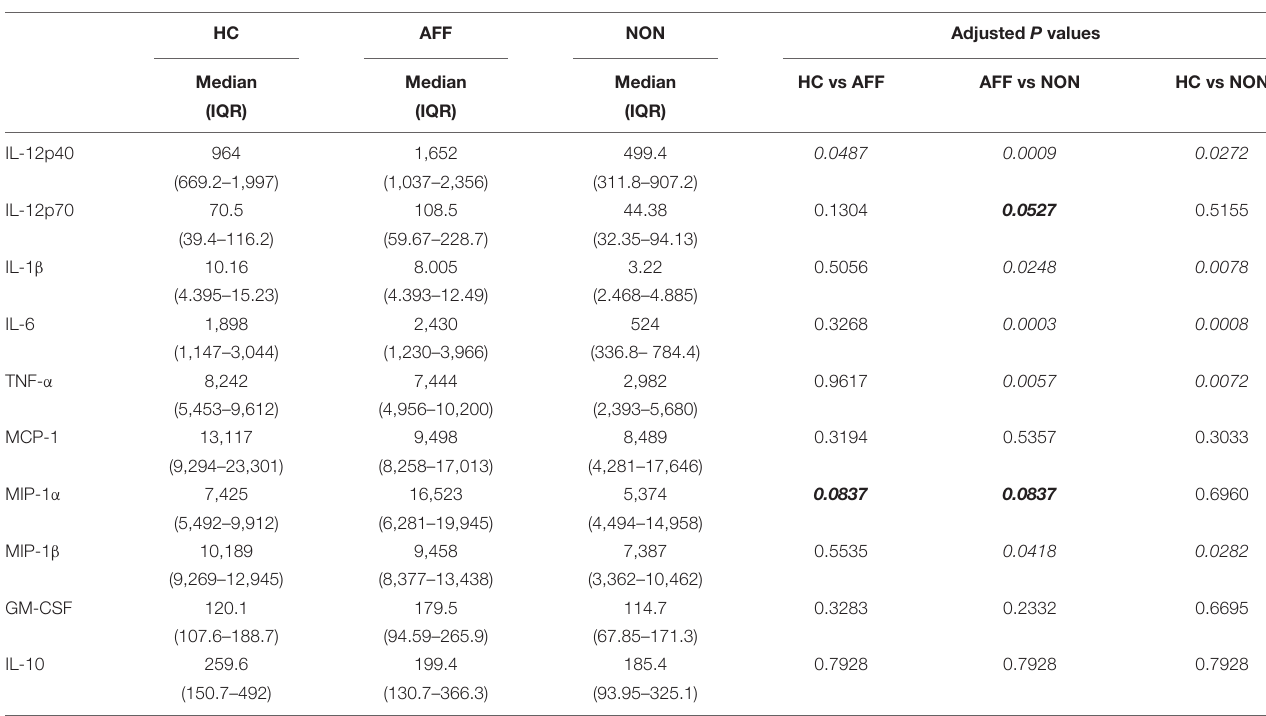
FIGURE 1 | Baseline (media only) cytokine/chemokine levels. Basal macrophage cytokine and chemokine production after culturing for 24 h in RPMI. Concentrations in pg/mL of IL-12p40 (A) and IL-6 (B) were significantly lower in the AFF group compared to the HC group. Box and whiskers graphs depict median, upper and lower interquartile ranges, * p < 0.05, ** p < 0.01. HC n = 23, AFF n = 14, and NON n = 11. TABLE 3 | Concentration of cytokines/chemokines after LPS